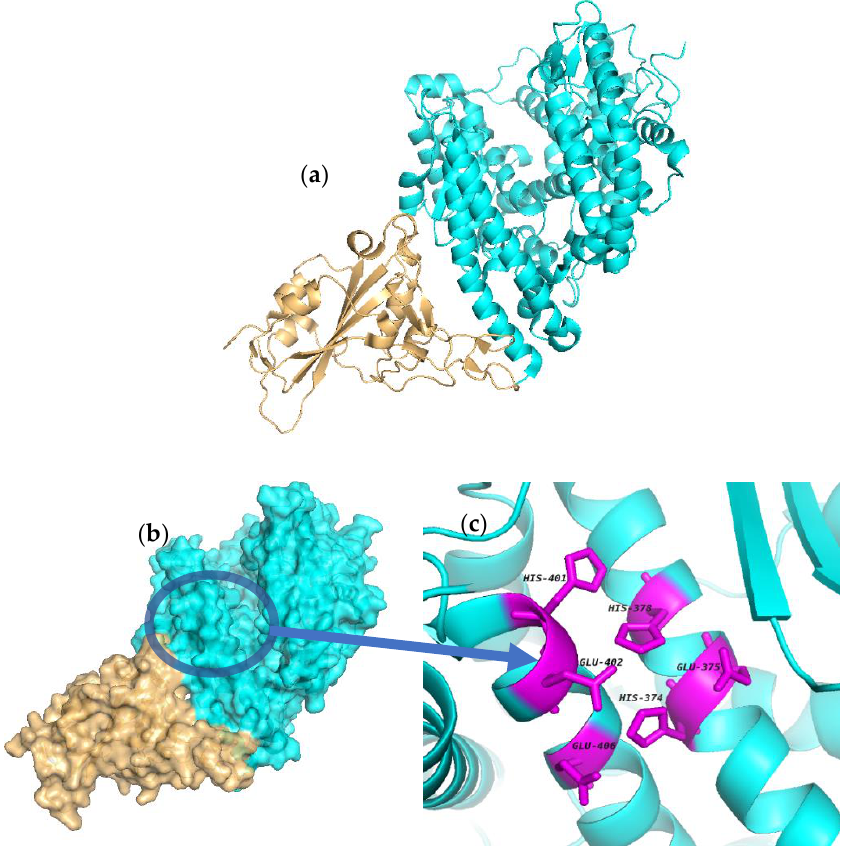
Figure 7. Structure of the SARS-CoV-2 receptor-binding domain (RBD) complexed with ACE2. ( a ) Crystal structure of the SARS-CoV-2 RBD complexed with ACE2. ACE2 is shown in cyan. RBD of SARS-CoV-2 is shown in gold. ( b ) Surface representation of protein 6M0J showing the binding site cleft. ( c ) Amino acid residues in the active site of ACE2 as highlighted in the literature [69–73]. The figures were generated using the software PyMol (Version 2.5.2.)